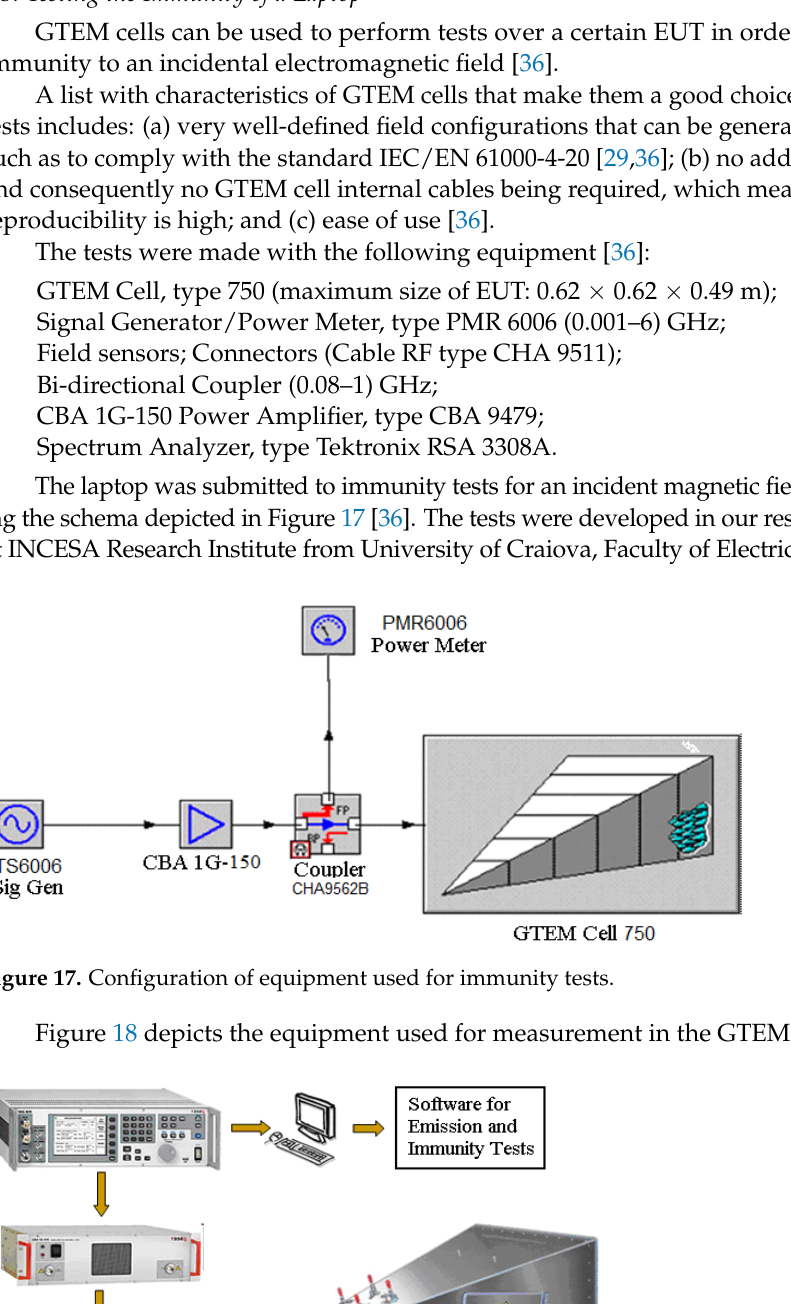
Figure 18. Schematic with the equipment used for measurement in GTEM cell 750 [36].